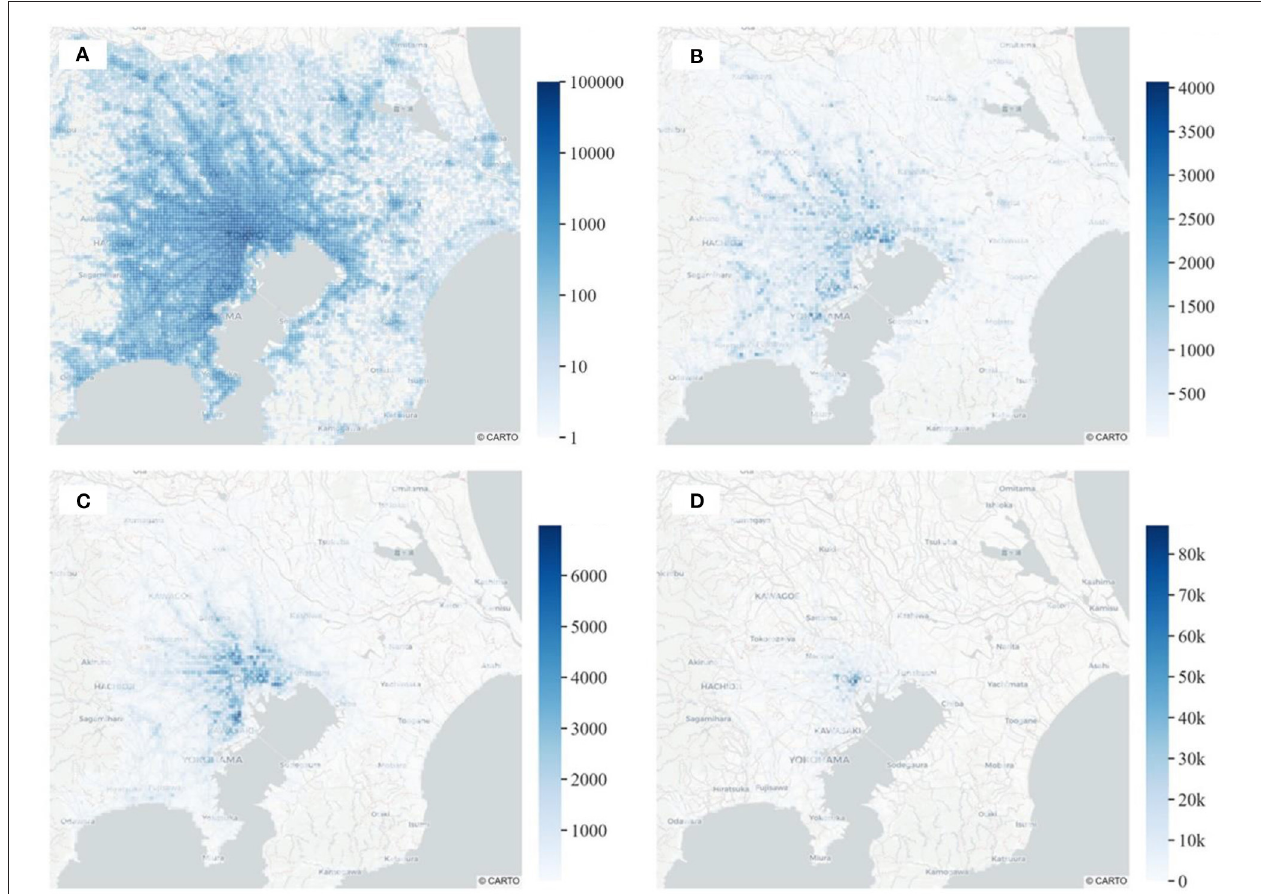
FIGURE 3 | Map of total daily trip origins per transport mode by (A) all transport modes, (B) car, (C) bicycle, and (D) train.